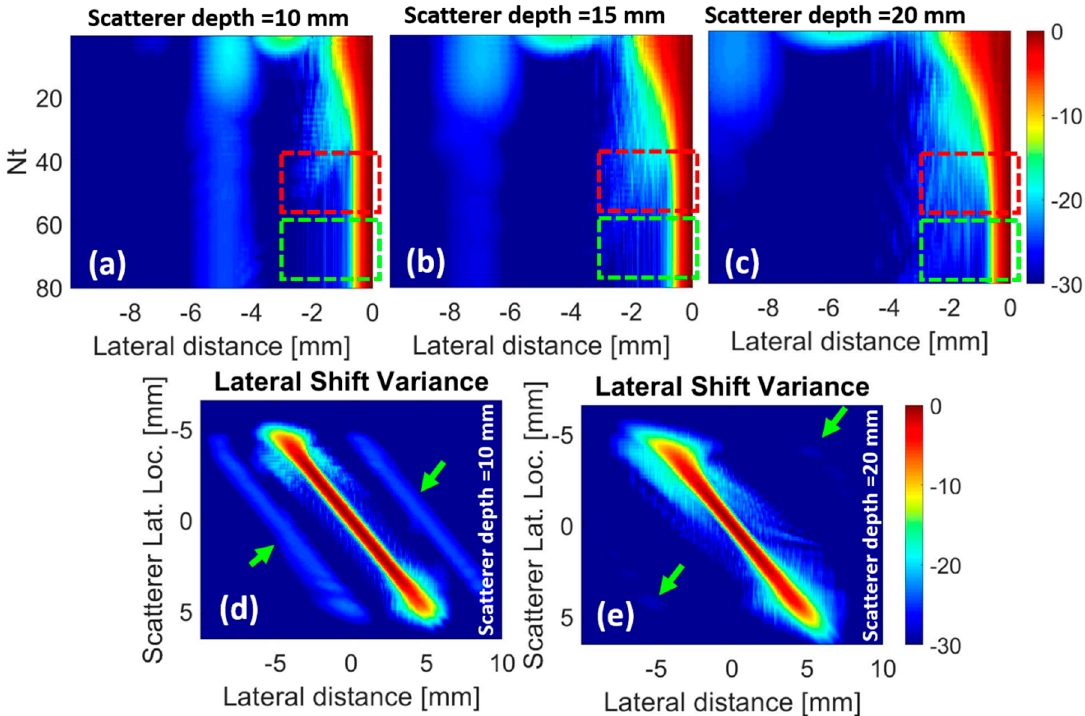
Figure 7. ( a – c ) The PSFs obtained for different Nt; Nr = 5, Ns = 3. The green rectangular regions show a reduction of sidelobes with respect to the red rectangles. ( d , e ) The lateral shift variance for full-aperture transmission, Nr = 5 and Ns = 3, for a scatter at a depth of ( d ) 10 mm and ( e ) 20 mm. Green arrows: location of grating lobes.